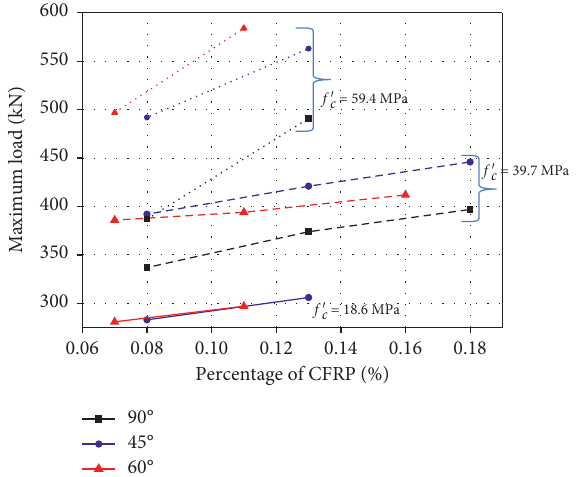
Figure 4: CFRP contribution against percentage of CFRP rein- forcement with various concrete compressive strength and NSM CFRP inclination